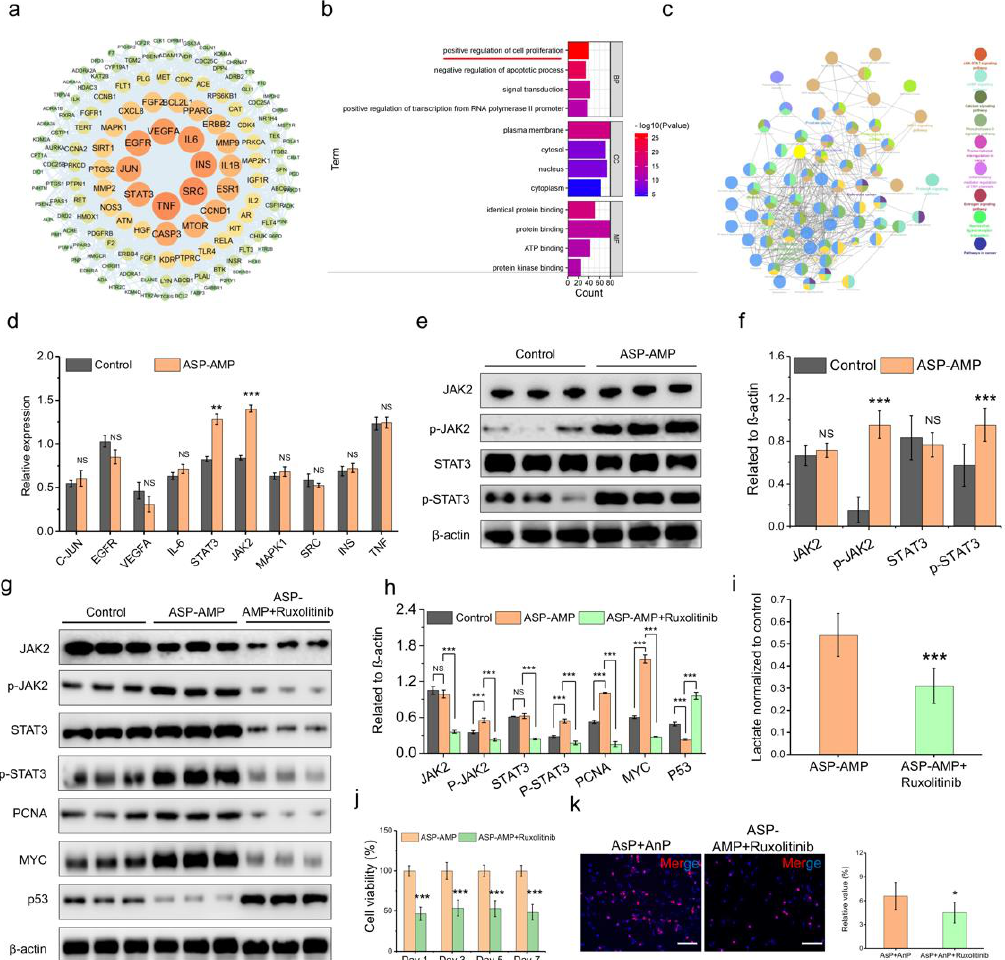
Figure 6. Activation of the JAK2/STAT3 signal pathway dominated the ASP-AMP-promoted liver regeneration. ( a ) PPI network of the common targets of drugs and liver regeneration. According to the degree value, the nodes were arranged from large to small and the color of the node changes from orange to yellow to green. ( b ) GO enrichment analysis. The top four terms in Biological Process, Cellular Component and Molecular Function are displayed. ( c ) The KEGG signaling pathway of ASP and AMP promoting liver regeneration. ( d ) RT-PCR analysis of predictive target factors in ASP-AMP promoted liver regeneration ( n = 3). ( e ) The expression of JAK2, p-JAK2, STAT3, and p-STAT3 in hepatocytes were analyzed by Western blot ( n = 3). ( f ) Densitometric analysis of grey value related to β -actin expression. ( g ) Pharmacologically inhibiting JAK2 downregulated the expression of p-STAT3, MYC, and PCNA, and upregulated p53 ( n = 3). ( h ) Quantitative analysis of protein expression related to β -actin. ( i ) Lactate expression in the supernatant of hepatocytes with ASP-AMP and/or ruxolitinib treatment for 3 days ( n = 3). ( j ) Cell viability of NCTC clone 1469 cells treated with ASP-AMP and/or ruxolitinib for 7 days ( n = 3). ( k ) Click-iT EdU proliferation staining of hepatocytes treated with ASP-AMP and/or ruxolitinib for 3 days and relative expression rates of positive EdU staining (scale bar = 100 µ m). * p < 0.05, ** p < 0.01, and *** p <